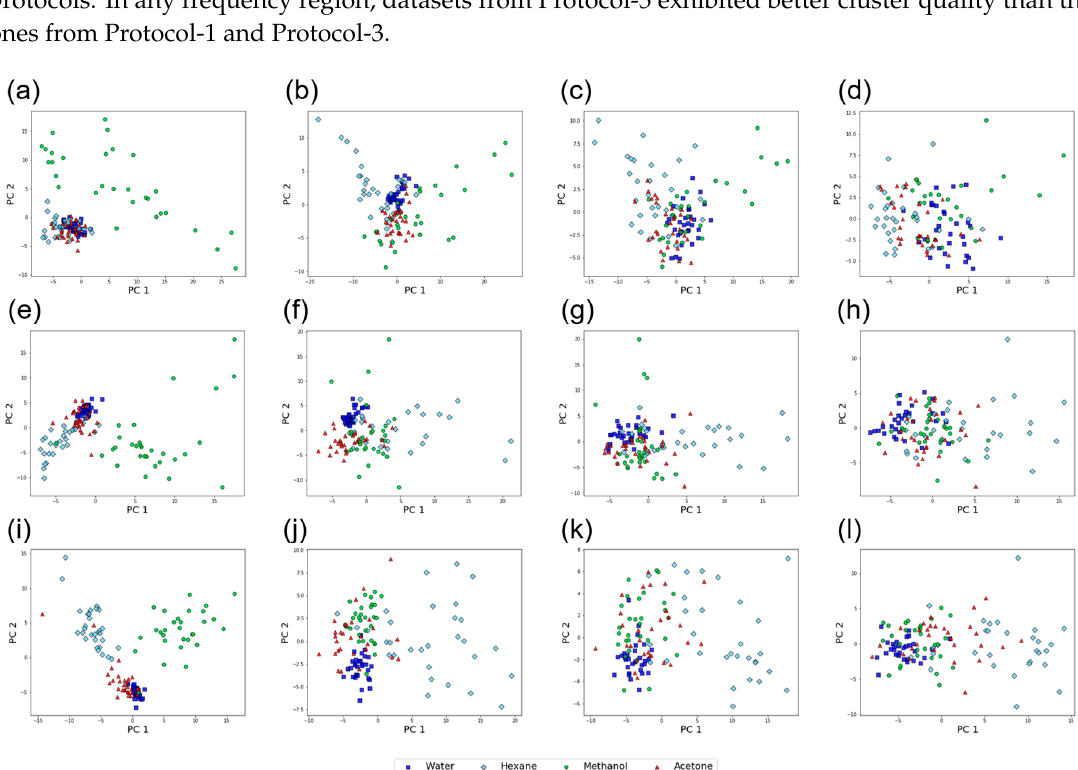
Figure 8. Colormap of Davies–Bouldin (DB) indices for the TFRs datasets. Classification models were also developed for each dataset. The accuracies of the classification models are summarized in Figure 9. Similar to the DB index, classification accuracy tends to deteriorate as the frequency range contained in a dataset becomes high. No significant difference is observed among the three protocols. Of all the classification models, the random forest-based